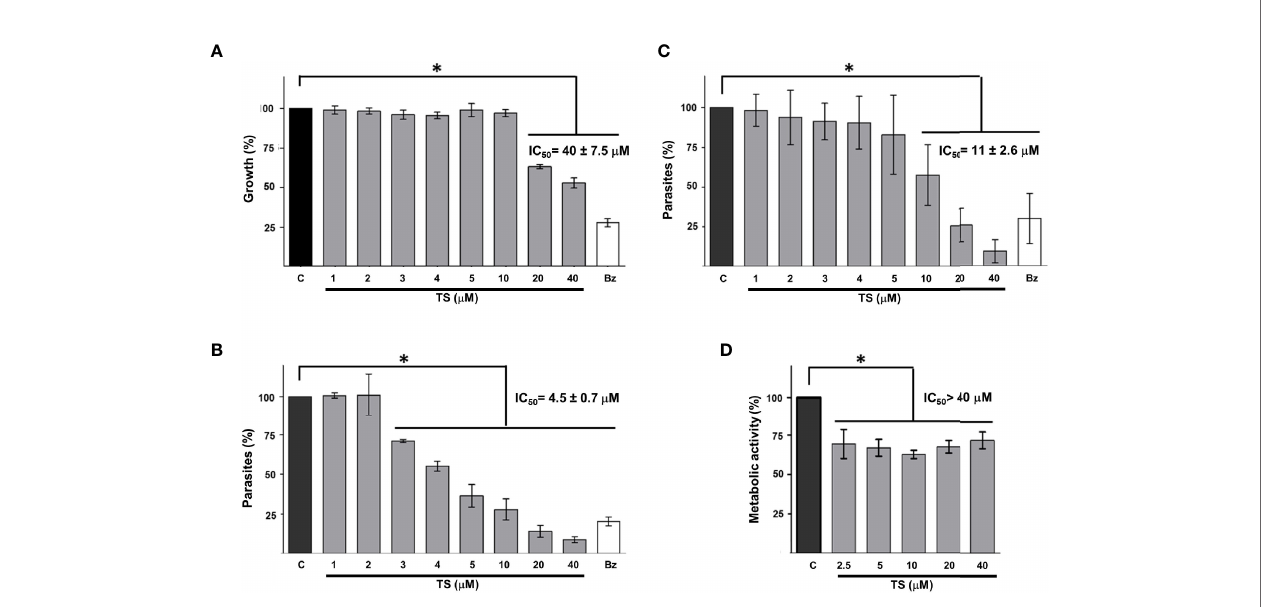
FIGURE 5 | Tripanocidal effect of TS. Epimastigotes (A) , cell-derived trypomastigotes (B) , blood trypomastigotes (C) , and Vero cells cytotoxicity (D) were incubated in the presence or absence of TS at the indicated micromolar concentrations. Parasite number was established by counting at 48 h (A) or 24 h (B, C) of incubation. Metabolic activity was measured using MTT assay at 24 h (D) . The results are presented as media ± standard deviation. Bz (25 m M) was used as a positive control. Media without TS (C) was used as control. Statistically signi fi cant differences are indicated with an asterisk (p <